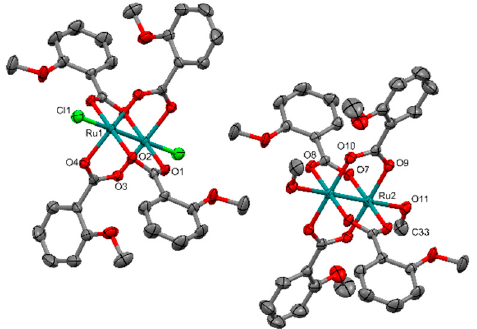
Figure 2. Bimetallic complexes of compound 1c . Ellipsoids are drawn at 50% probability level. Hydrogen atoms are omitted for clarity.